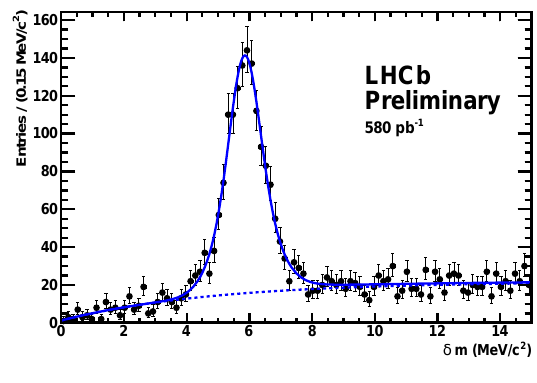
Fig. 3. Example fit used in the ∆ A CP analysis. The first kinematic bin of the first run period with magnet up polarity is shown for the D 0 → K − K + final state.